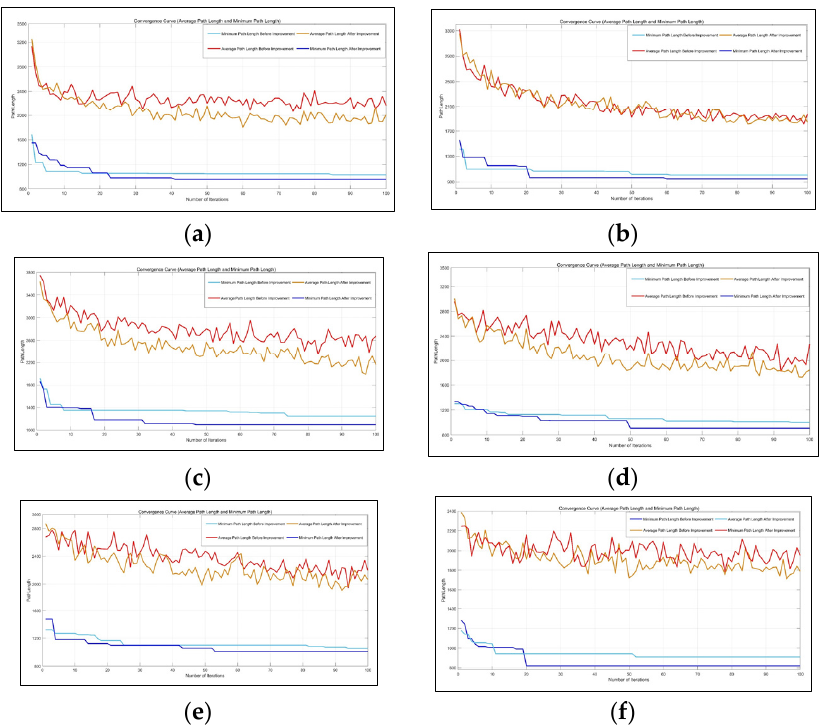
Figure 9. The path convergence curve comparison chart. ( a ) Comparison of path convergence curves for point 1, ( b ) Comparison of path convergence curves for point 2, ( c ) Comparison of path convergence curves for point 3, ( d ) Comparison of path convergence curves for point 4, ( e ) Comparison of path convergence curves for point 5 and ( f ) Comparison of the three-dimensional path of point 6.